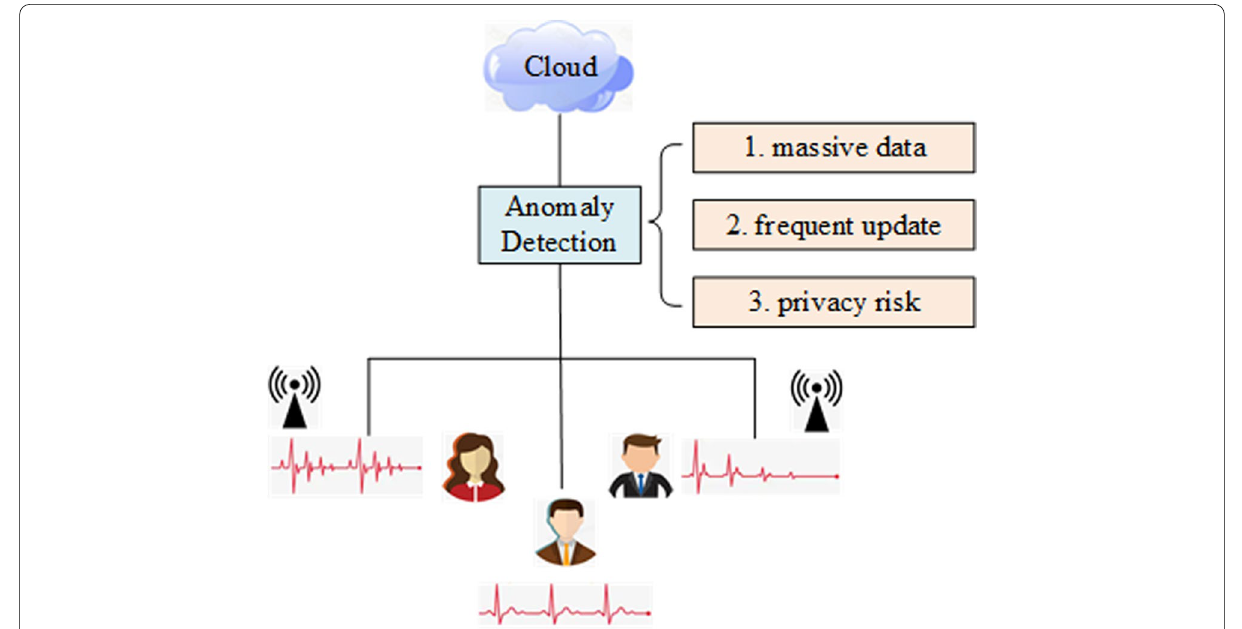
Fig. 1 Anomaly detection of health data with wearable sensors in mobile cloud computing: